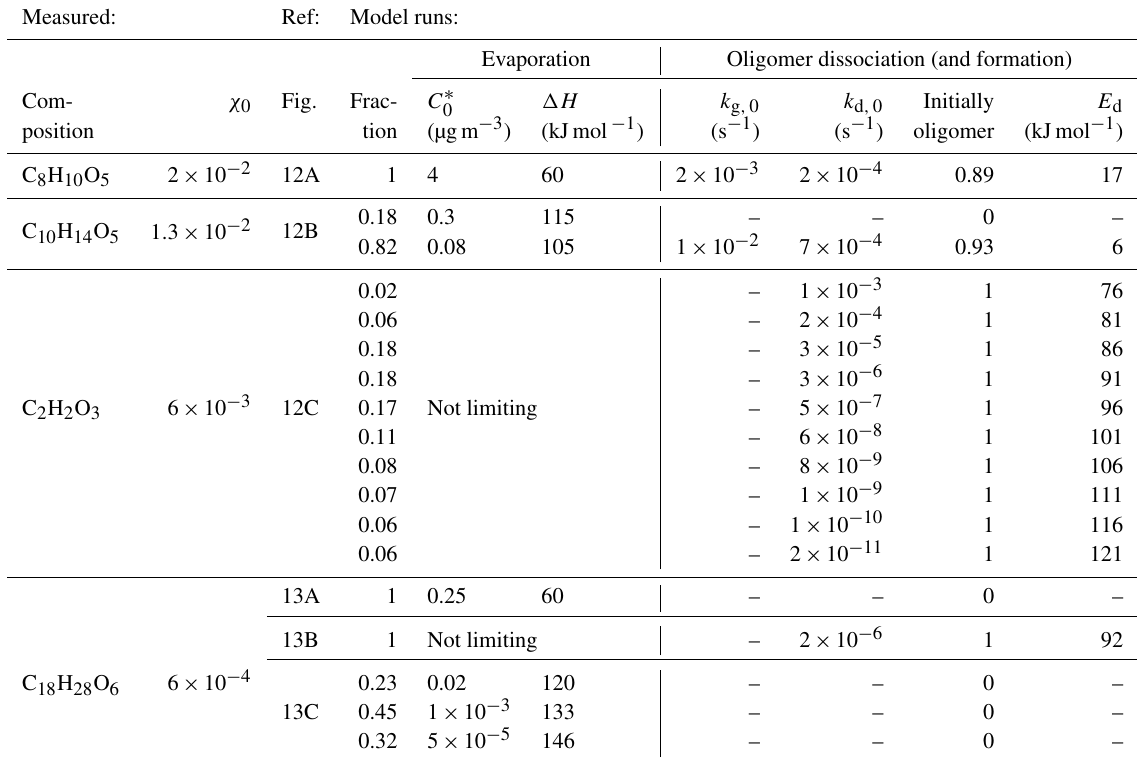
Table 3. Free parameters used for the model runs in Figs. 12 and 13, analogous to Table 2. Measured: Ref: Model runs: Evaporation Oligomer dissociation (and formation) Com- χ 0 Fig. Frac- position